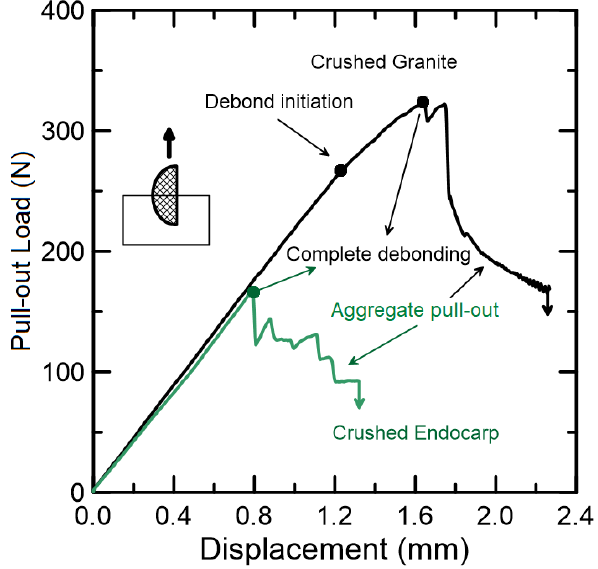
Figure 15. Typical pull-out curves for crushed granite and endocarp.